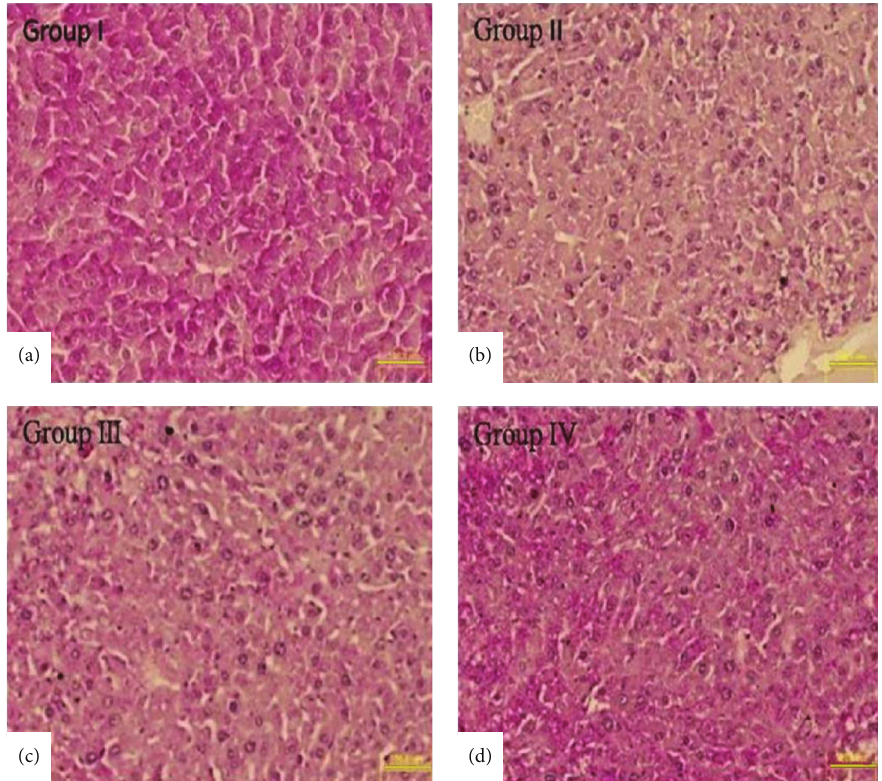
Figure 9: PAS staining for the storage of glycogen in liver sections of Group I to Group IV (a–d) (200x, scale bar ∼ 100 𝜇